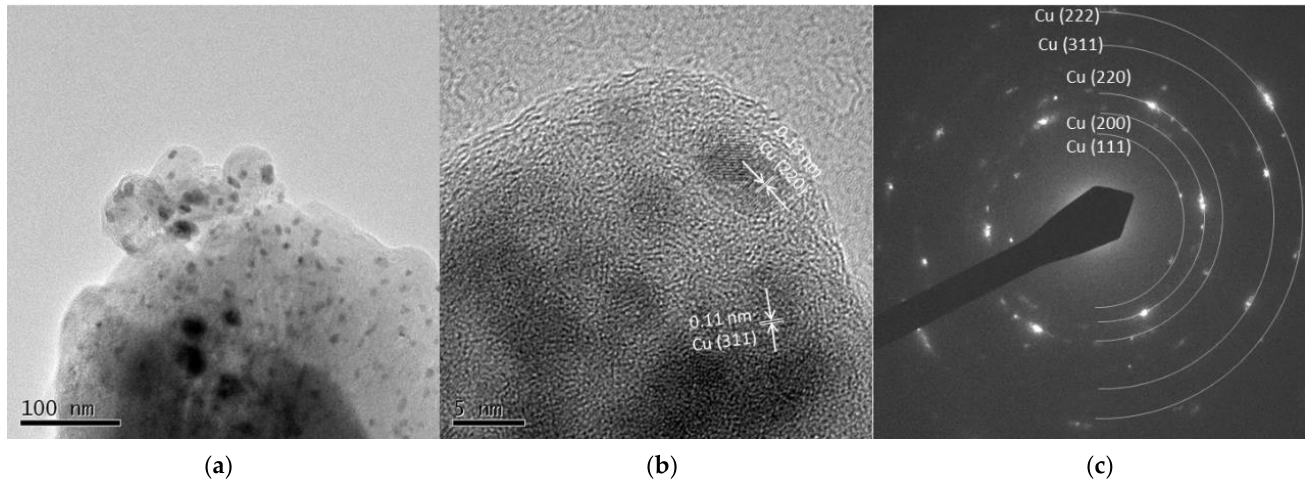
Figure 10. TEM images of Cu 30 A particles ( a ) low resolution image; ( b ) high resolution image; ( c ) SAED pattern